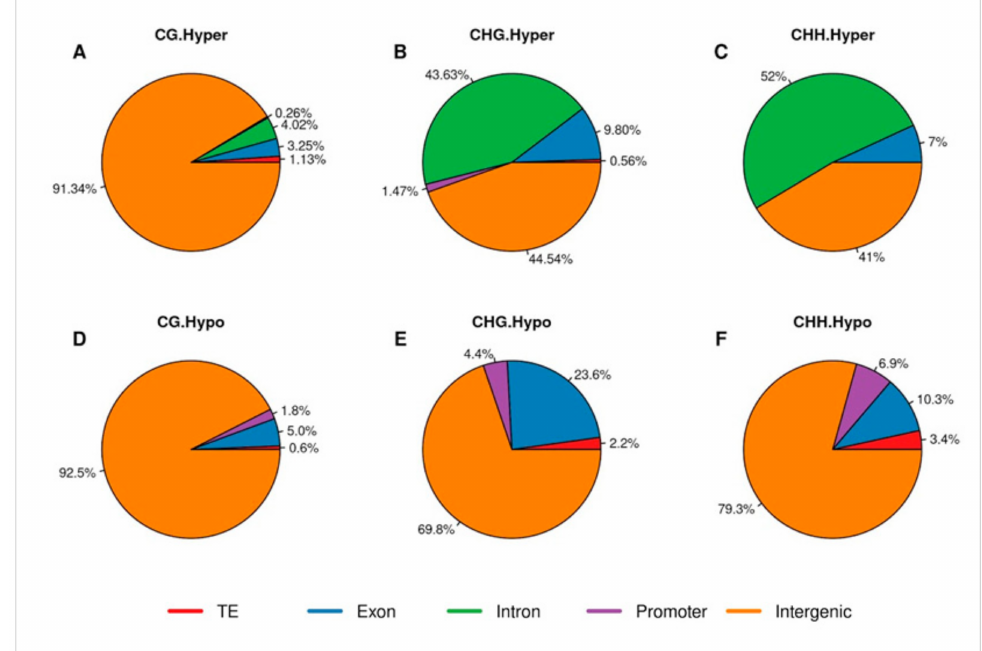
Figure 4. Distribution of genomic elements with hypo-DmCs and hyper-DmCs in the whole genome for each context. ( A ) hyper-CG. ( B ) hyper-CHG. ( C ) hyper-CHH. ( D ) hypo-CG. ( E ) hypo-CHG. ( F ) hypo-CHH. Transposable elements (TE) in red colour; exons in blue colour; introns in green colour; promoter region (2 kb upstream of TSS and 2 kb downstream of TES) in purple colour; intergenic regions in orange